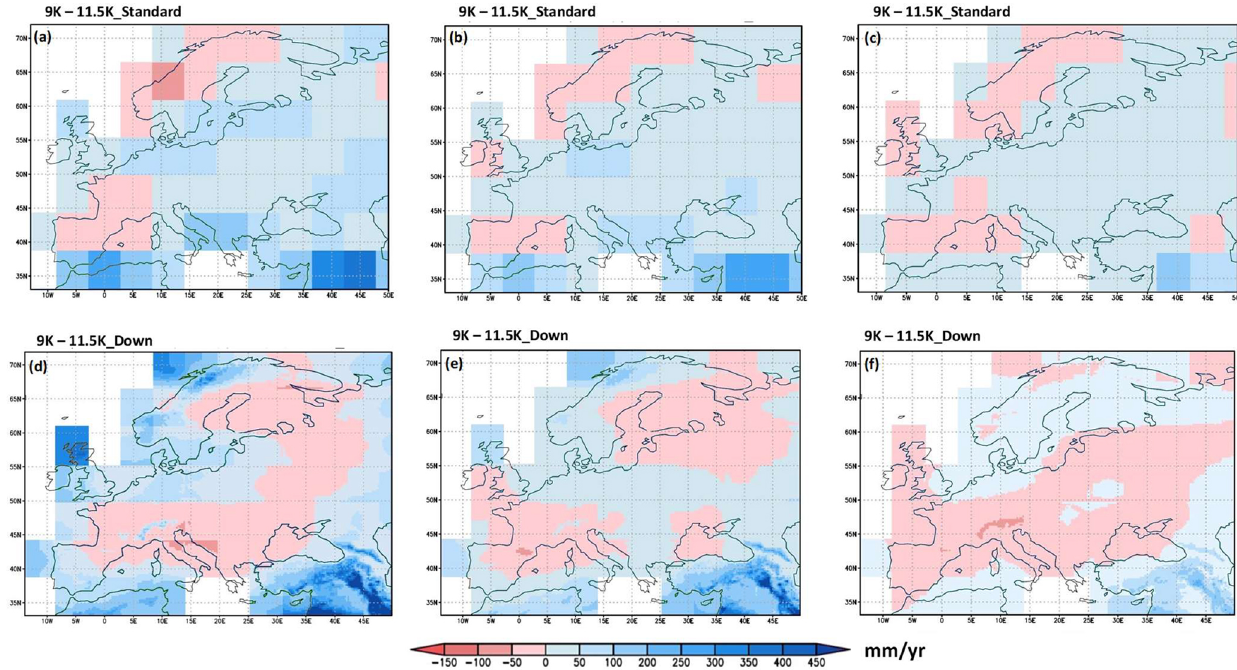
Figure 4. Simulated mean annual precipitation anomalies (in mmyr − 1 , results minus the pre-industrial mean) showing spatial distribution in Europe for 9kaBP (a, d) , 6kaBP (b, e) , and 3kaBP (c, f) for 11.5K_Standard and